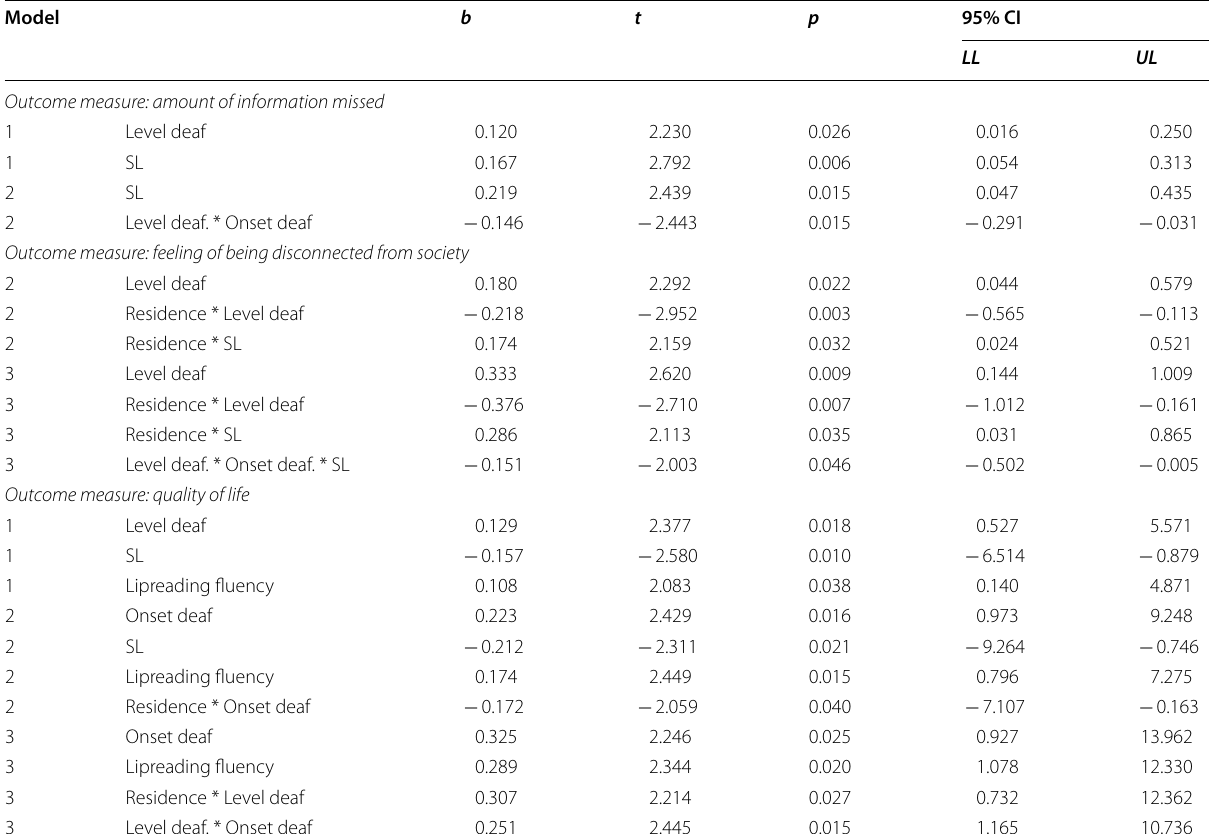
Table 5 Summary of significant effects in the regression analysis amount of missed information, feeling of being disconnected from society, and